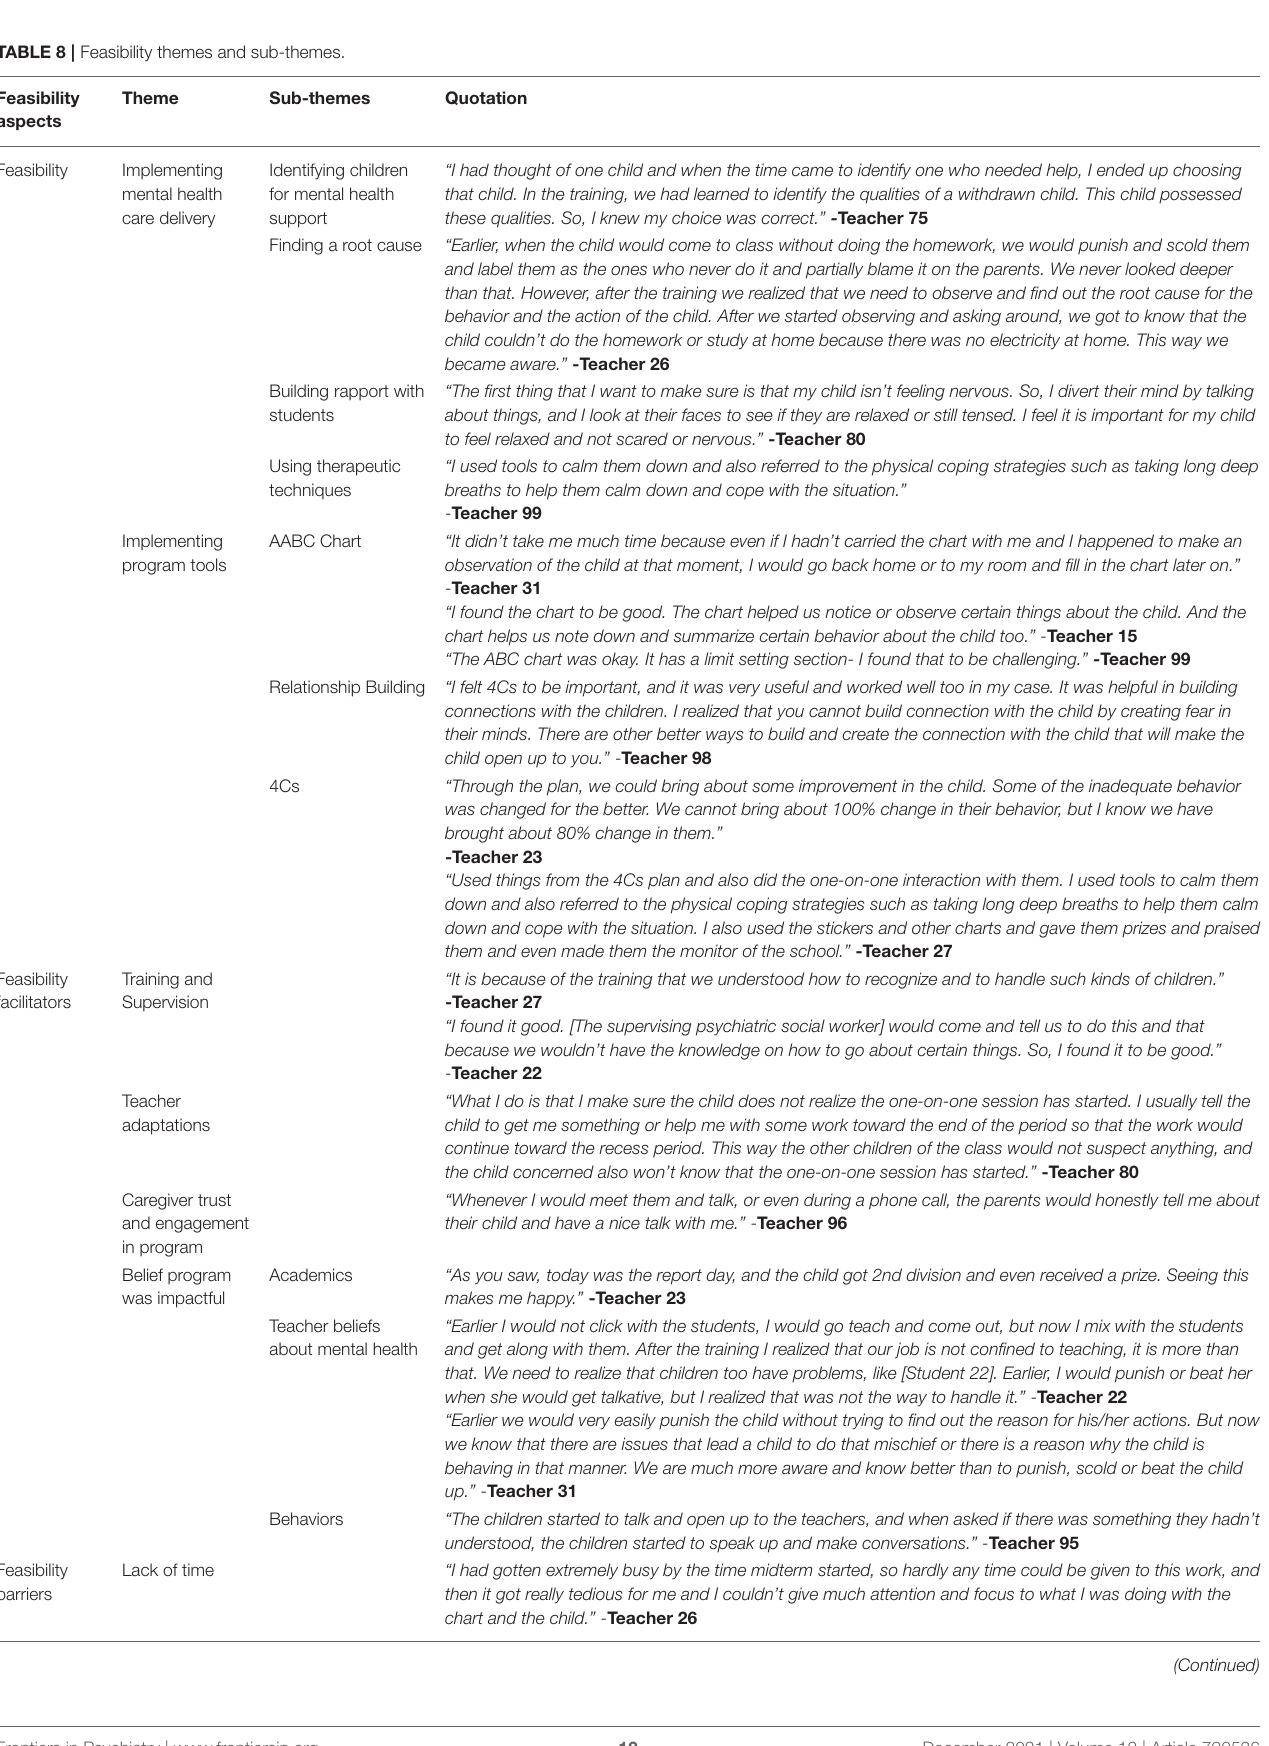
TABLE 8 | Feasibility themes and sub-themes. Feasibility